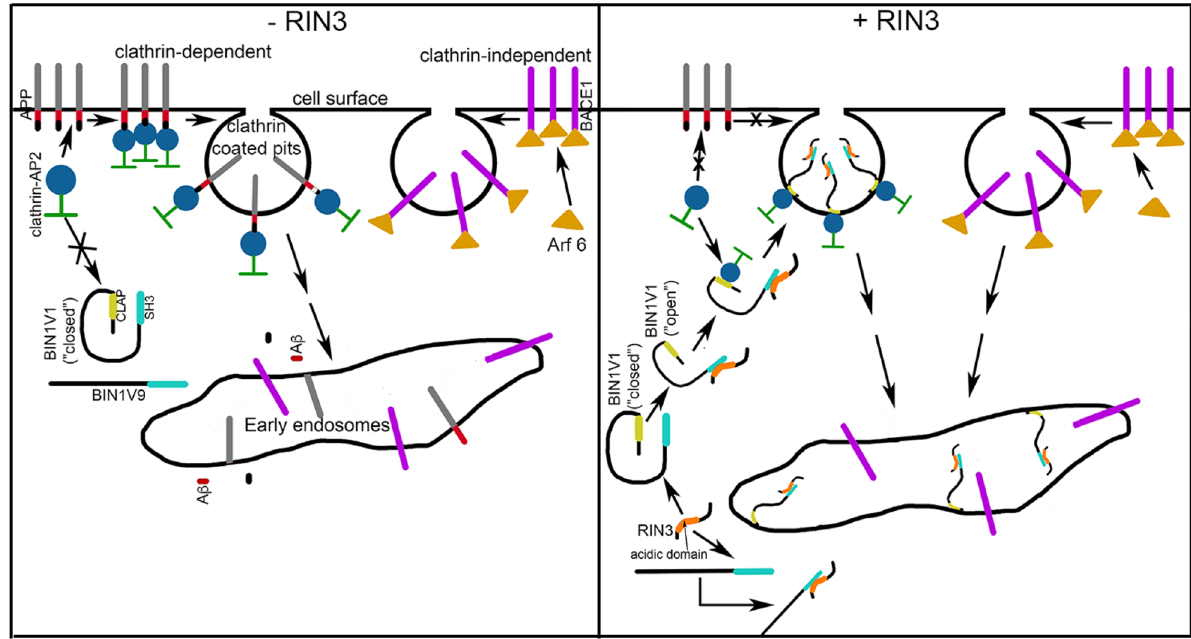
Figure 5. Schematic representation of BIN1V1 regulation of endosomal transport of APP in a RIN3-dependent manner. In absence of RIN3 (-RIN3, left panel) APP and BACE1 undergo clathrin-dependent (via binding to AP2-clathrin complex) and clathrin-independent (via Arf6 binding) internalization, respectively, into early endosomes where APP is cleaved by β-secretase and γ-secretase (not shown) to generate Aβ (red) and the APP intracellular domain (AICD; black). BIN1V1 remains in a “closed” form via intramolecular interaction between its CLAP and SH3 domains. (BIN1V9 does not have CLAP domain.) In the presence of RIN3 (+ RIN3, right panel ) the SH3 domain of BIN1V1 binds to the acidic domain of RIN3 to “open” BIN1V1. The CLAP domain of BIN1V1 is then “open” to interact with the AP2-clathrin complex and translocates to endosomes via clathrin- dependent internalization. APP is excluded from the clathrin-pits, and is left on the cell surface, owing to either unavailability of AP2-clathrin complex or “steric hindrance” by RIN3-bound “open” BIN1V1. In contrast, clathrin-independent BACE1 internalization into early endosome remains unaltered by BIN1V1/BIN1V9-RIN3 interactions. This serves to separate APP and BACE1 into different cellular compartments, leading to attenuated generation of